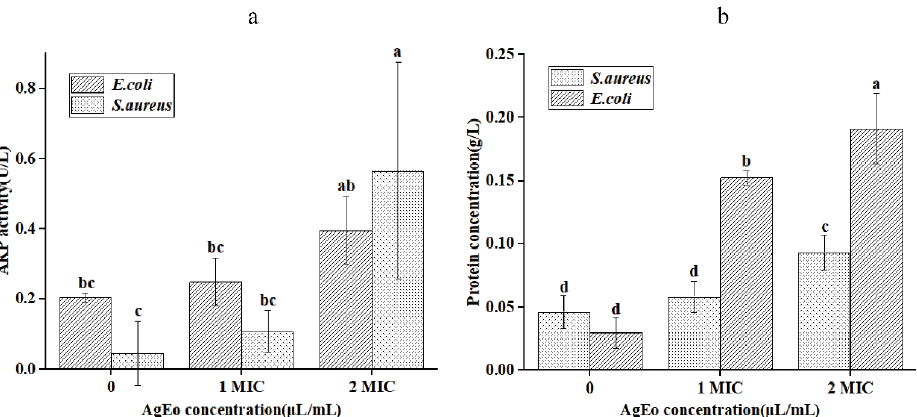
Figure 9. The alkaline phosphatase activity ( a ) and protein content ( b ). Different normal letters indicate significant differences between treatments ( p < 0.05, n = 3).